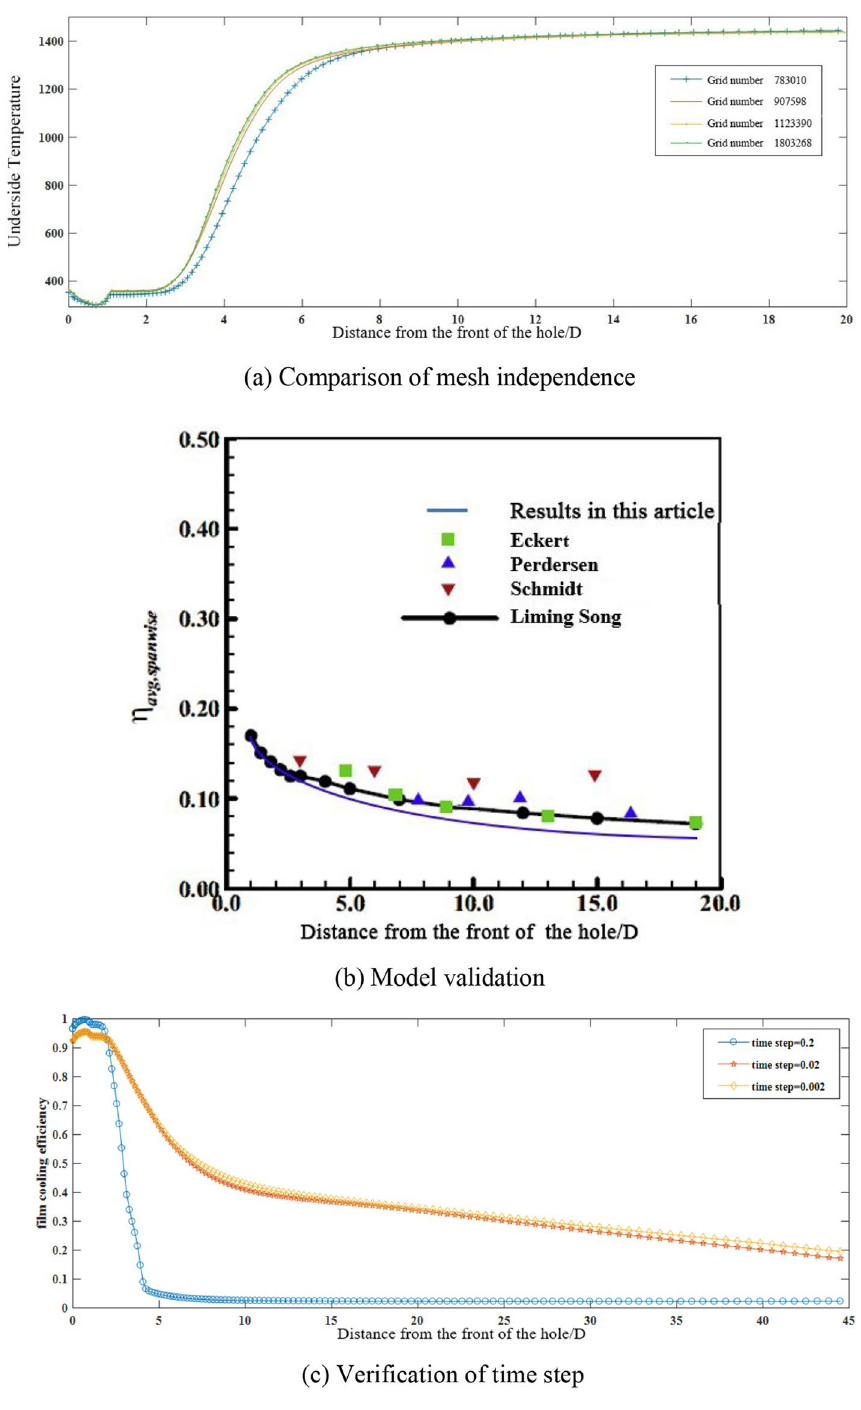
Figure 3. Model verification of